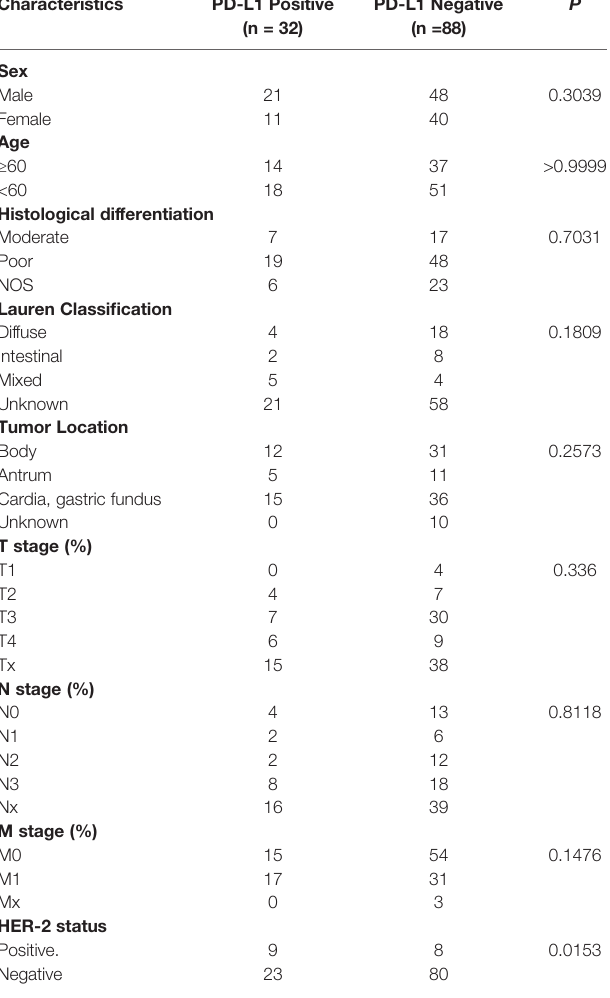
TABLE 1 | Clinicopathologic and baseline clinical features of gastric cancer patients.